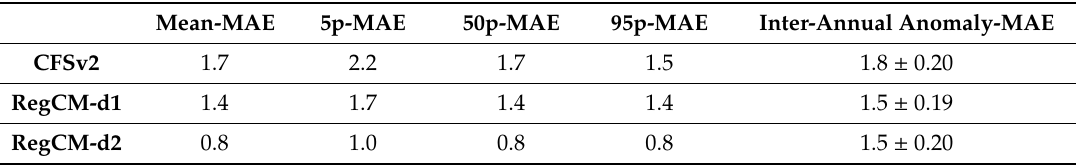
Table 1. Mean absolute error (MAE) for daily mean 2 m temperature of the climatological period in the, 5th, 50th, and 95th percentiles, and inter-annual anomaly variability for the three SFSs compared to the reanalysis. In the rightmost column, the standard deviation represents the ensemble spread from the ensemble mean anomaly MAE. The five metrics are averaged over the winter season. Units are ◦ C. See text for details.